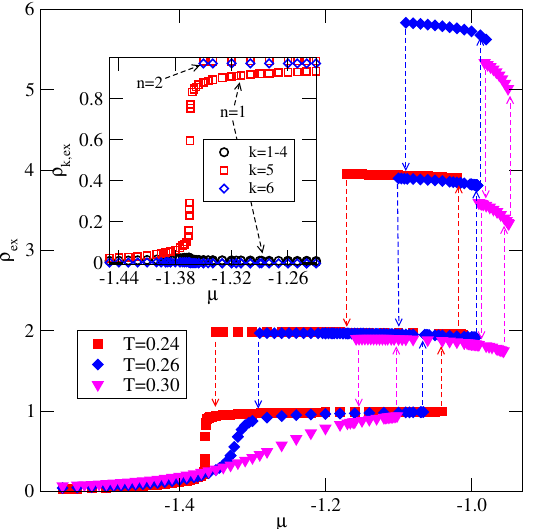
Figure 22. The excess adsorption isotherms for the system with V A = − 0.8 and V B = − 0.4. The inset shows changes of excess densities of differently oriented particles along the parts of adsorption and desorption isotherms, at T = 0.15, in the region of stability of monolayer and bilayer film.